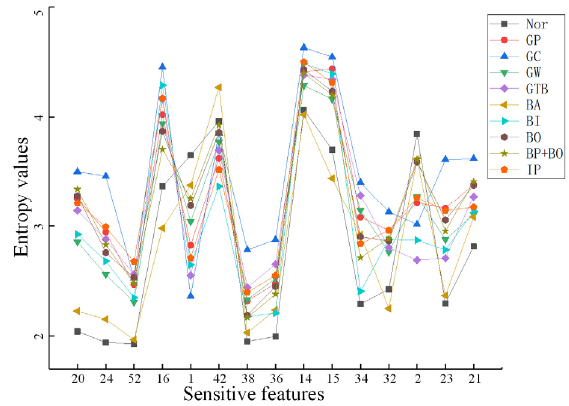
Figure 20. Sensitive fault features of different states.